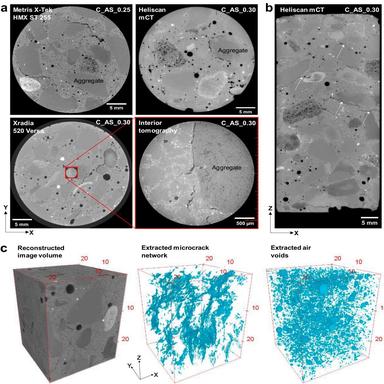
X-ray μCT images of C-AS cores. a, Comparison of imaging results across different scanners. b, Orthogonal view of C-AS-0.30 core. c, Extracted microcrack network and air voids from the reconstructed image volume of C-AS-0.25 core. All dimensions in μm.